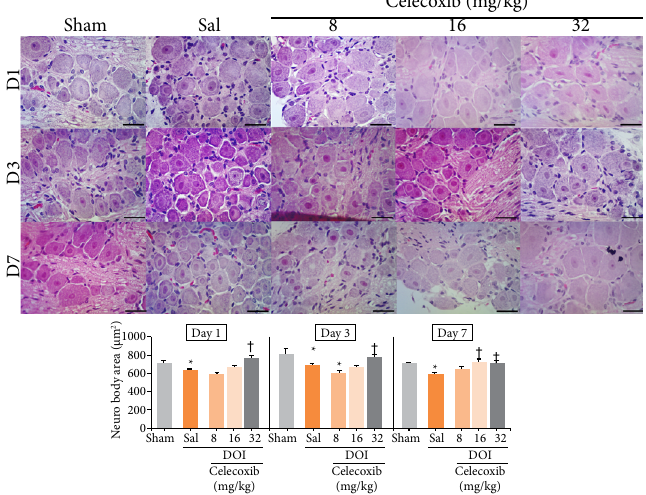
Figure 2 - Histomorphometric analysis of contralateral cell body area of trigeminal neurons in rats treated with different doses of a selective cyclooxygenase 2 inhibitor (celecoxib, Eurofarma ® ) and exposed to an experimental model of dental occlusal interference. Two-way analysis of variance (ANOVA)/Bonferroni (mean ± standard error); hematoxylin and eosin, 400×, horizontal line = 50 μ